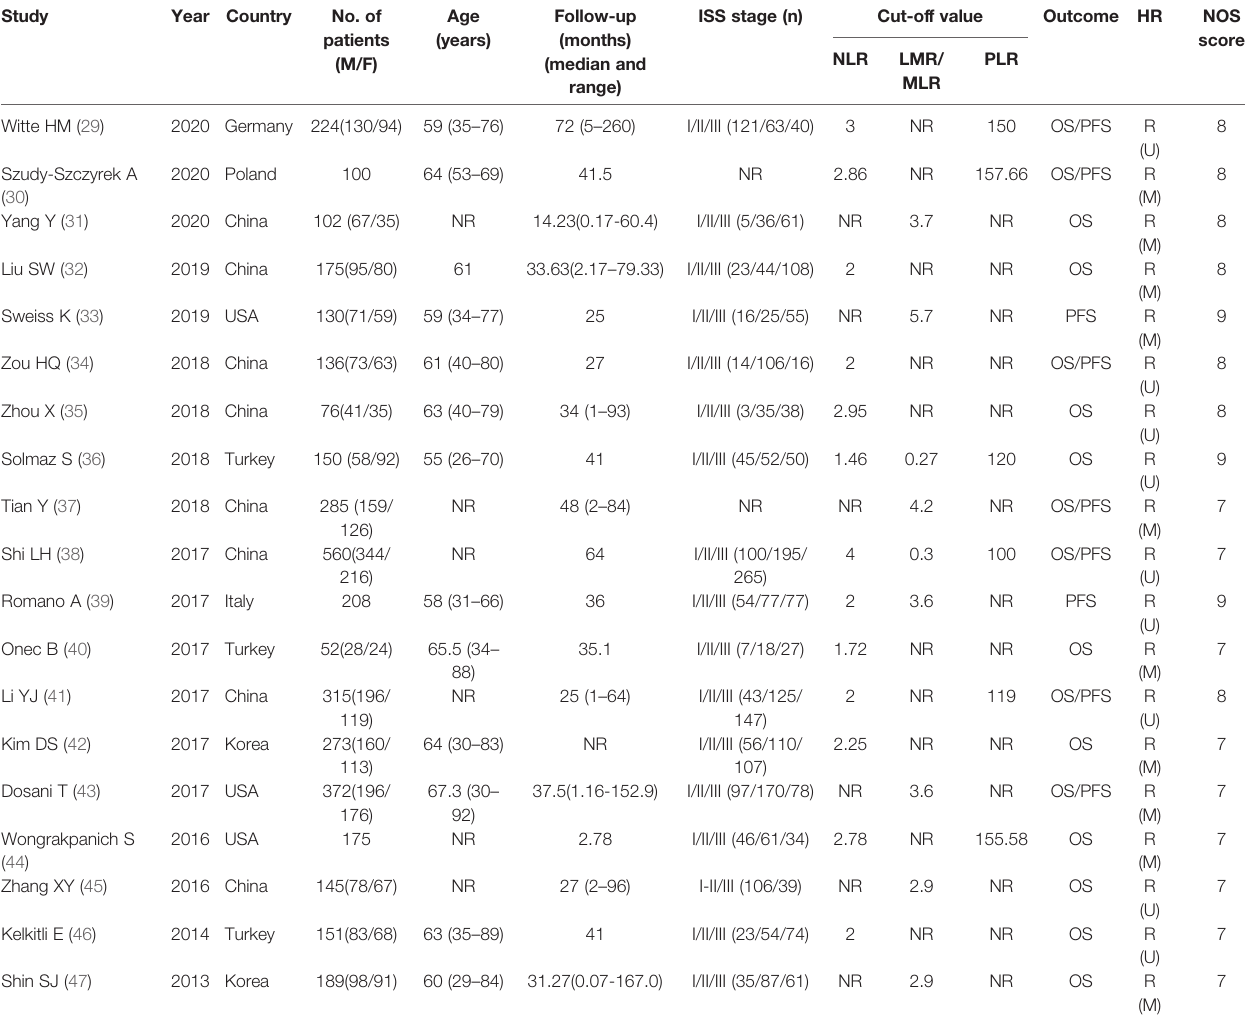
TABLE 1 | Main characteristics of all the studies included in the